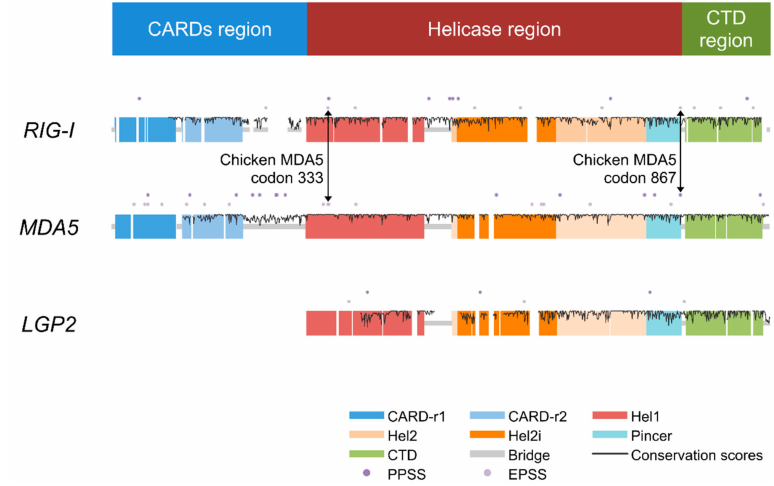
Figure 1. Overview of the three avian RIG-I-like receptors (RLRs). The double-sided black arrows indicate positively selected sites (PSSs) at identical positions in melanoma differentiation-associated gene 5 ( MDA5 ) and retinoic acid-inducible gene I ( RIG-I ). The bar at the top indicates the locations of three regions of the RLR genes defined for convenience in this paper. Meanings of dots, colored blocks, and lines in the domain structure sketch of three avian RLRs are denoted in the bottom right of the figure. Conservation scores were calculated only for the sites containing <5% missing data and deletions in